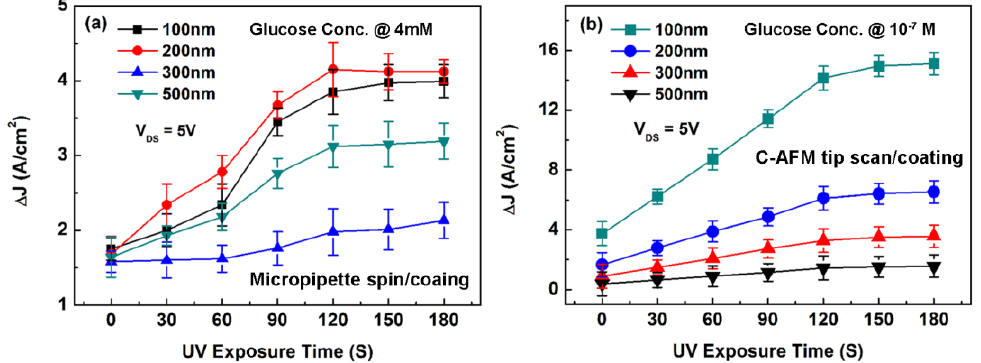
Figure 6. Current density changes ΔJ as a function of UV exposure time for PSWs with different line widths coated with γ-APTES+NPs membrane by (a) micropipette/spin-coating, and (b) C-AFM tip